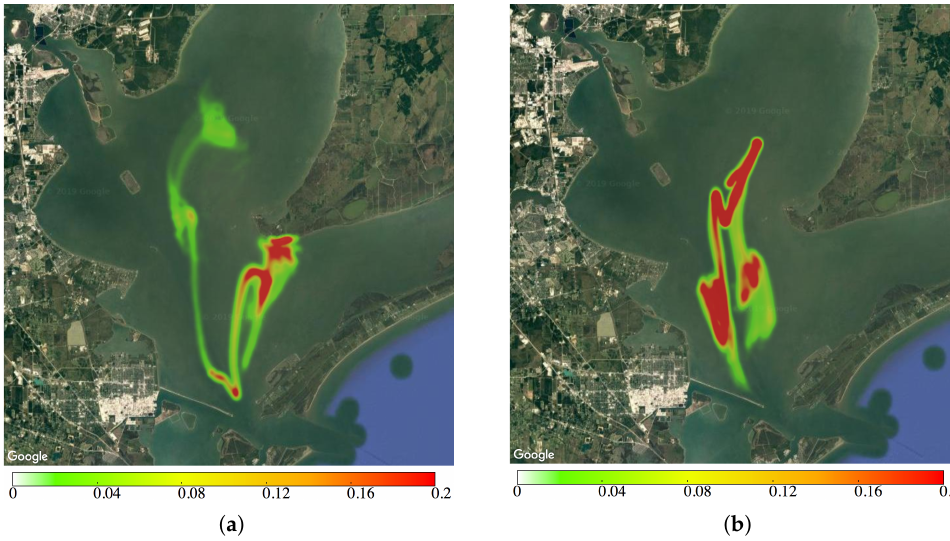
Figure 12. The probability map of the multi-model integration for ( a ) Case 1 and ( b ) Case